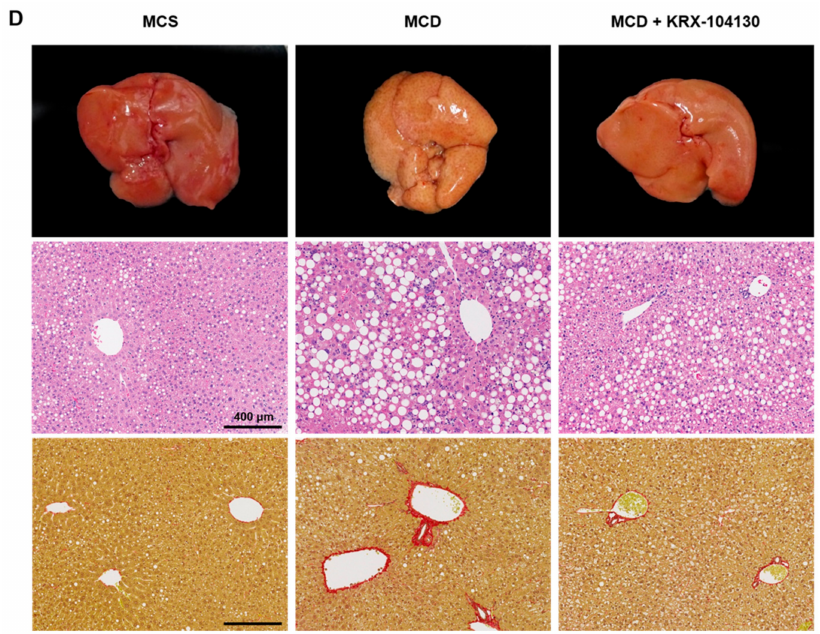
Figure 8. Effect of KRX-104130 treatment in a mouse model of NASH. The MCD diet-induced hepatic injury, steatosis, and fibrosis were ameliorated by treatment with KRX-104130. ( A ) Liver TG levels; ( B , C ) Serum ALT and AST levels; ( D ) Representative gross liver appearance (upper panel), and liver sections stained with hematoxylin and eosin (middle panel) and picrosirius Red (bottom panel) in different groups of mice. Data are presented as mean ± S.E.M. Statistical differences between experi- mental groups were determined by One-way ANOVA ( n = 6–10 for each group). * p < 0.05 vs. MCS group; # p < 0.05 vs. MCD group. TG, triglycerides; AST, aspartate aminotransferase; ALT, alanine aminotransferase; MCD, methionine-and choline-deficient; MCS, methionine-choline